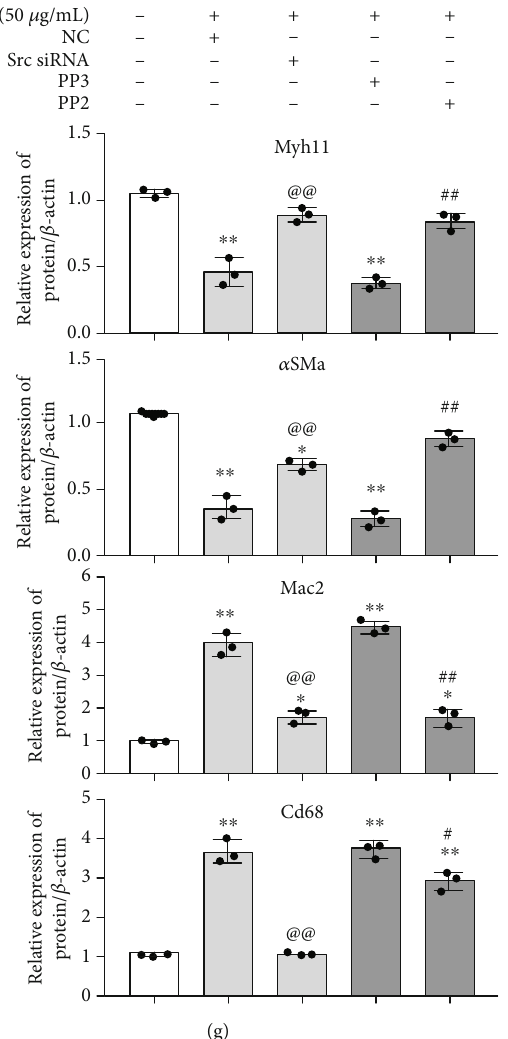
Figure 5: Knockdown or inactivation of Src regulated lipid accumulation and cellular phenotype in VSMCs. (a, b) Tlr4(-) or NC were treated with or without oxLDL (50 μ g/mL) for 1 hour; the activation of Src (Tyr-418, Y418) had been detected by western blot. ( n = 3 per group, results were expressed as mean ± SD ; ∗∗ P < 0 : 01 , as compared with oxLDL-untreated NC group; ## P < 0 : 01 , as compared with oxLDL- treated NC group.) Src was knockdown by siRNA transfection within VSMCs. The Src-speci fi c antagonist, PP2, was used to block Src activation, with PP3 serving as the negative control. The VSMCs were treated with and without 50 μ g/mL oxLDL for 48 hours. (c, d) The Src-speci fi c [Src (-)] and negative control (NC) siRNA were, respectively, transfected into VSMCs for 72 hours, and the knockdown e ffi ciency was detected. ( n = 3 per group, results were expressed as mean ± SD ; ∗∗ P < 0 : 01 , as compared with the NC group.) (e) Nile Red (orange) was used to label the lipid, and the concentration of intracellular lipid was measured. ( n = 5 per group, results were expressed as mean ± SD ; ∗∗ P < 0 : 01 , as compared with the untreated group; @@ P < 0 : 01 , the oxLDL-treated Src siRNA group compared with the oxLDL-treated NC group; ## P < 0 : 01 , the oxLDL-treated PP2 group compared with the oxLDL-treated PP3 group.) (f, g) Western blot was conducted to measure the VSMC contractile phenotype markers (Myh11 and α Sma) and foam cell markers (Mac2 and Cd68). All the western blot results were calculated using grayscale value, and β -actin served as an internal reference gene to normalize protein expression. ( n = 3 per group, results were expressed as mean ± SD ; ∗∗ P < 0 : 01 , as compared with the control group (untreated group); @@ P < 0 : 01 , the oxLDL-treated Src siRNA group compared with the oxLDL-treated NC group; ## P < 0 : 01 , the oxLDL-treated PP2 group compared with oxLDL-treated PP3